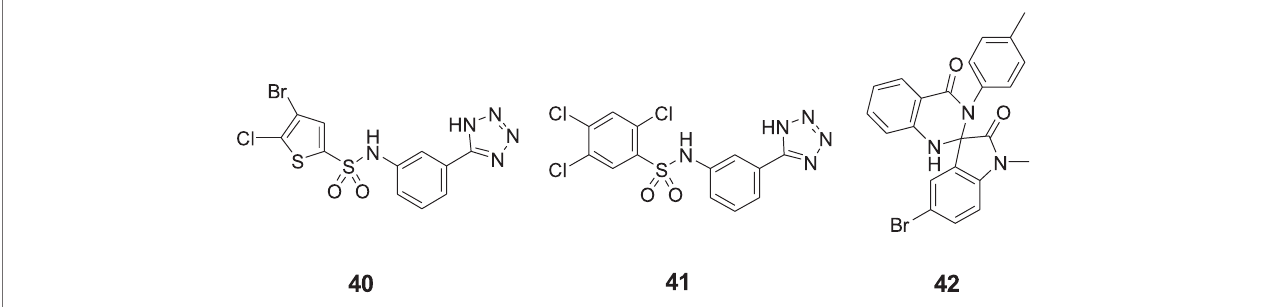
Figure 10 | The sulfonamides 40 and 41 and the spiro-oxindole dihydroquinazolinone 42 were identi fi ed after screening a substance library of 10,500 low- molecular-weight compounds.